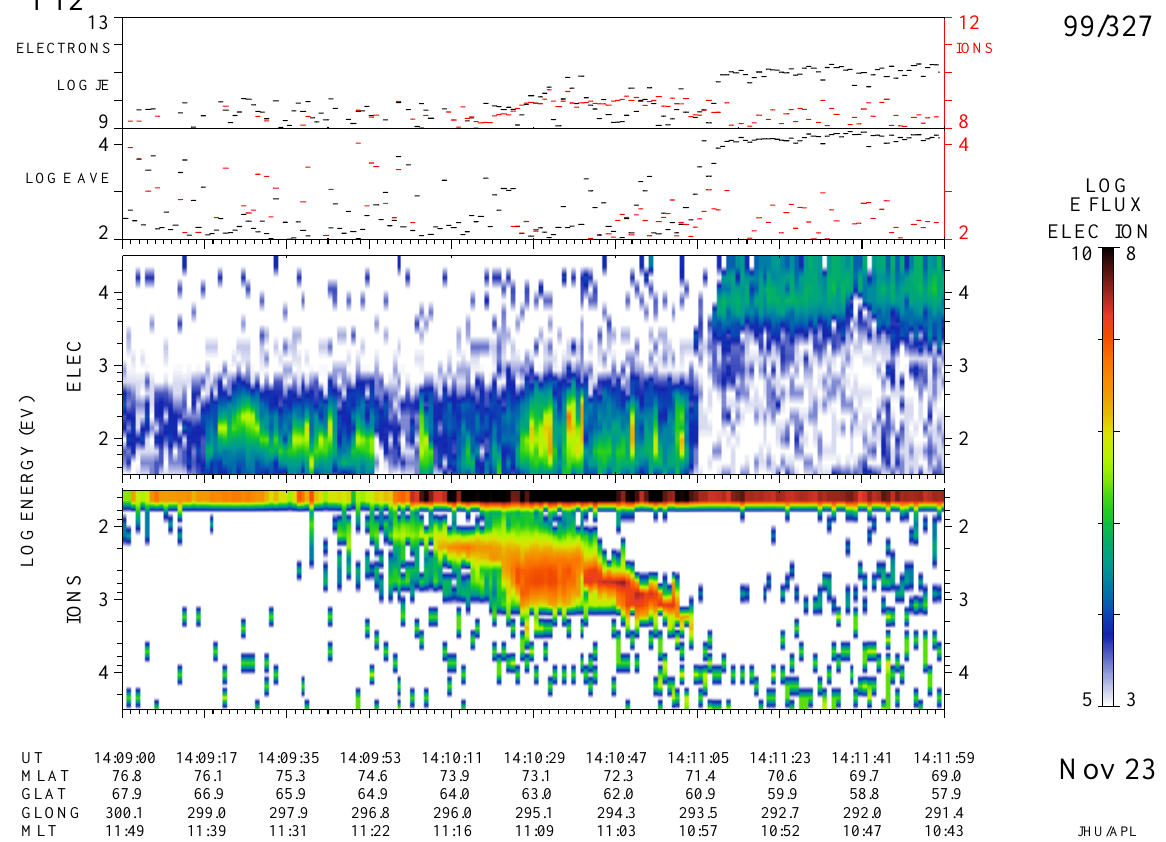
Fig. 5. Particle observations during a pass by the DMSP-F12 satellite through the open-closed field line boundary on 23 November 1999. The top two panels give the integral energy flux and average energy of down-going electrons (in black) and ions (in red). The lower two panels show electron and ion spectrograms: the differential energy flux (in cm − 2 s − 1 sr − 1 ) is contoured on a log scale as a function of observation time and energy. Note that the energy scale is inverted (i.e. energy increases down the page) for the bottom panel (for ions). For each UT, the geomagnetic latitude (MLAT), geographic latitude (GLAT), geographic longitude (GLONG) and magnetic local time (MLT) of the spacecraft are given. This example shows a pass through an active reconnection X-line footprint in the pre-noon sector near 11:00 MLT (see text for